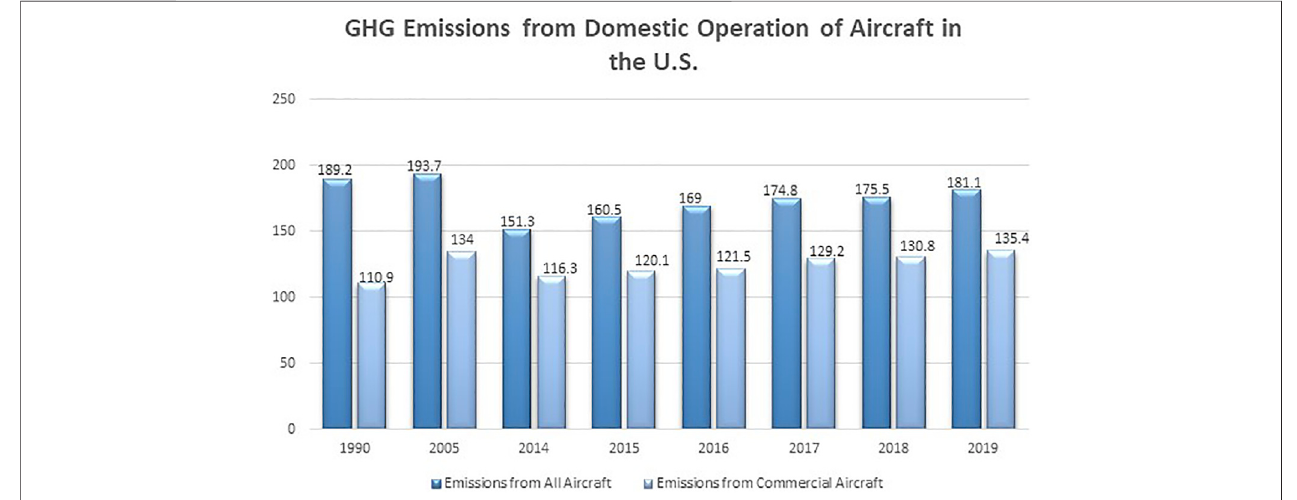
FIGURE1| GHGEmissionsfromdomesticaircraftoperationintheU.S.(EPA,2021,at3 – 24;preparedbasedondatafromEPAInventoryofU.S.GreenhouseGas Emissions and Sinks: 1990 – 2019).